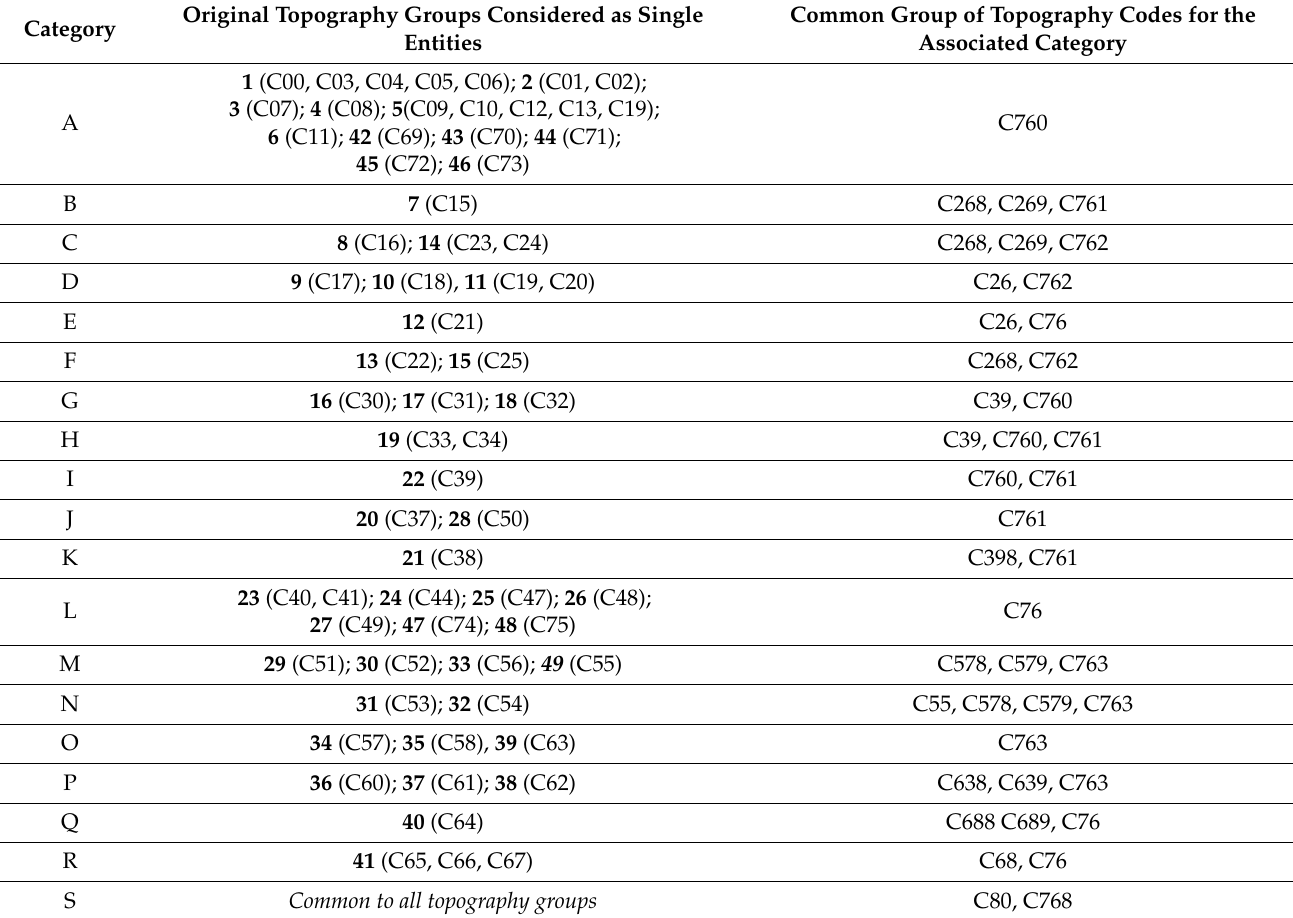
Table A1. Further categorisation of topography codes to circumvent duplication of codes in the main groups. The original 48 groups (indicated in bold font) correspond with the rows taken consecutively in Table 9 of